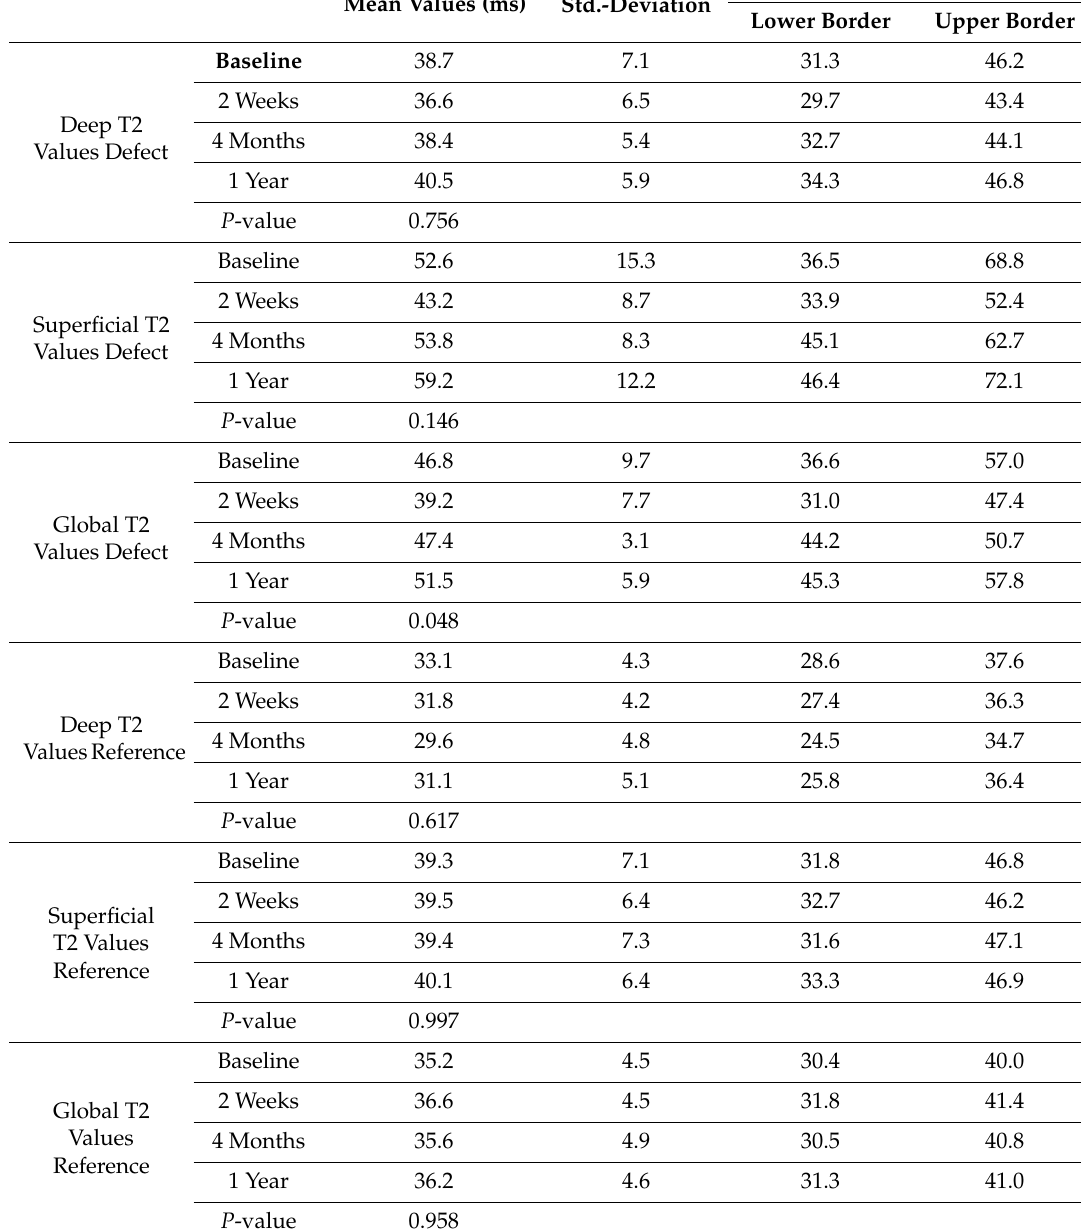
Table 1. Values of all measurements of the deep, superficial and global zone of the cartilage defect and the reference cartilage over the time course, beginning with the preoperative baseline measurement, followed by measurements at two weeks, four month and 12 months after